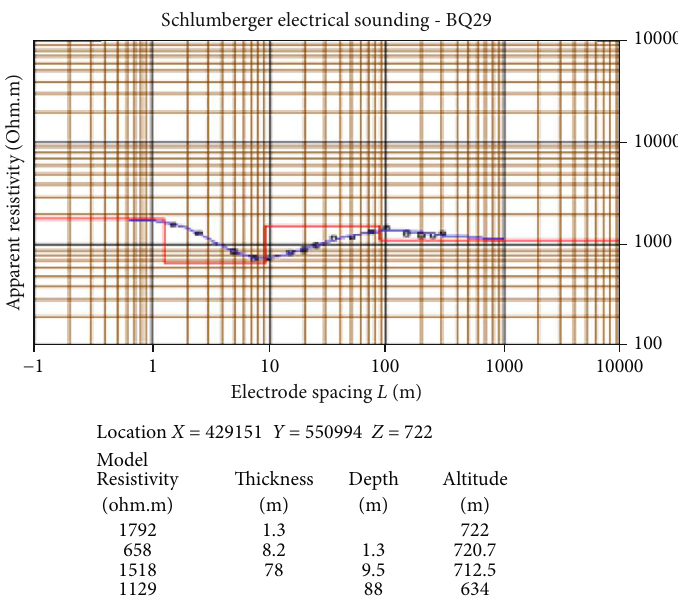
Figure 8: Sounding curve (BQ